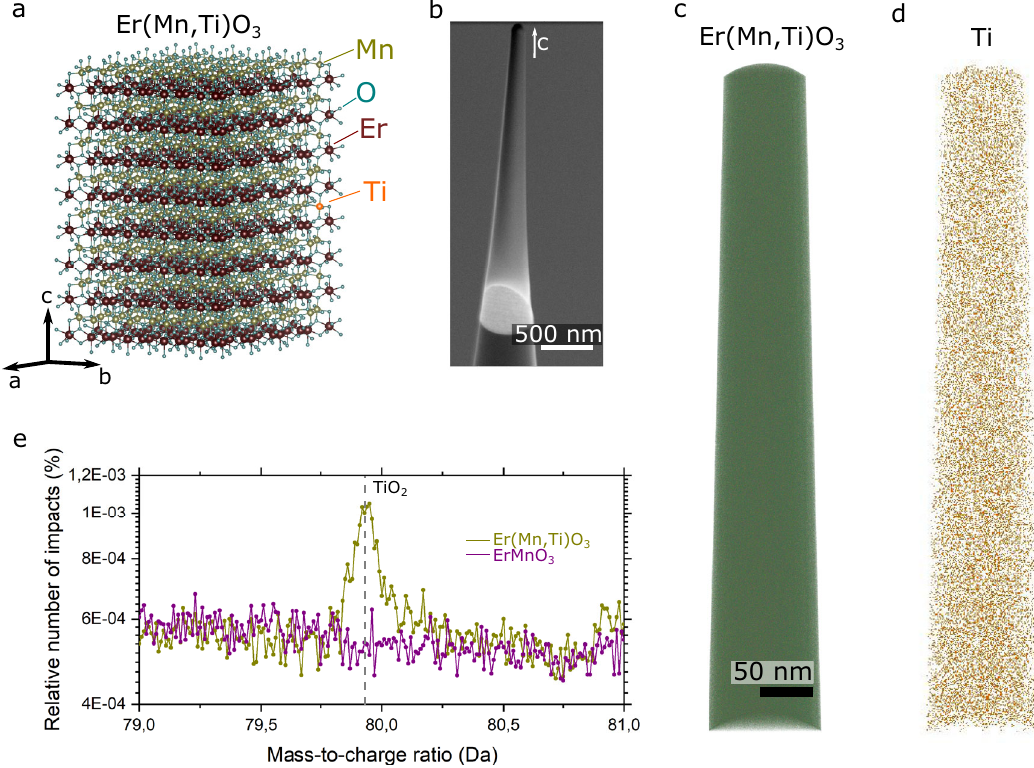
Fig.1|SEMandAPTimagesofaneedle-shapedEr(Mn,Ti)O 3 sample.a Illustration ofthecrystallographicstructureofEr(Mn,Ti)O 3 ,showingtheratiobetweenErMnO 3 lattice atoms and Ti dopants. For a dopant concentration of about 0.04 at.%, there is approximately one Ti atoms per 64 unit cells of ErMnO 3 . b Scanning electron microscopy (SEM) image of a FIB-cut needle specimen with the crystallographic c -axis oriented along the needle axis. c APT dataset gained from the needle shown